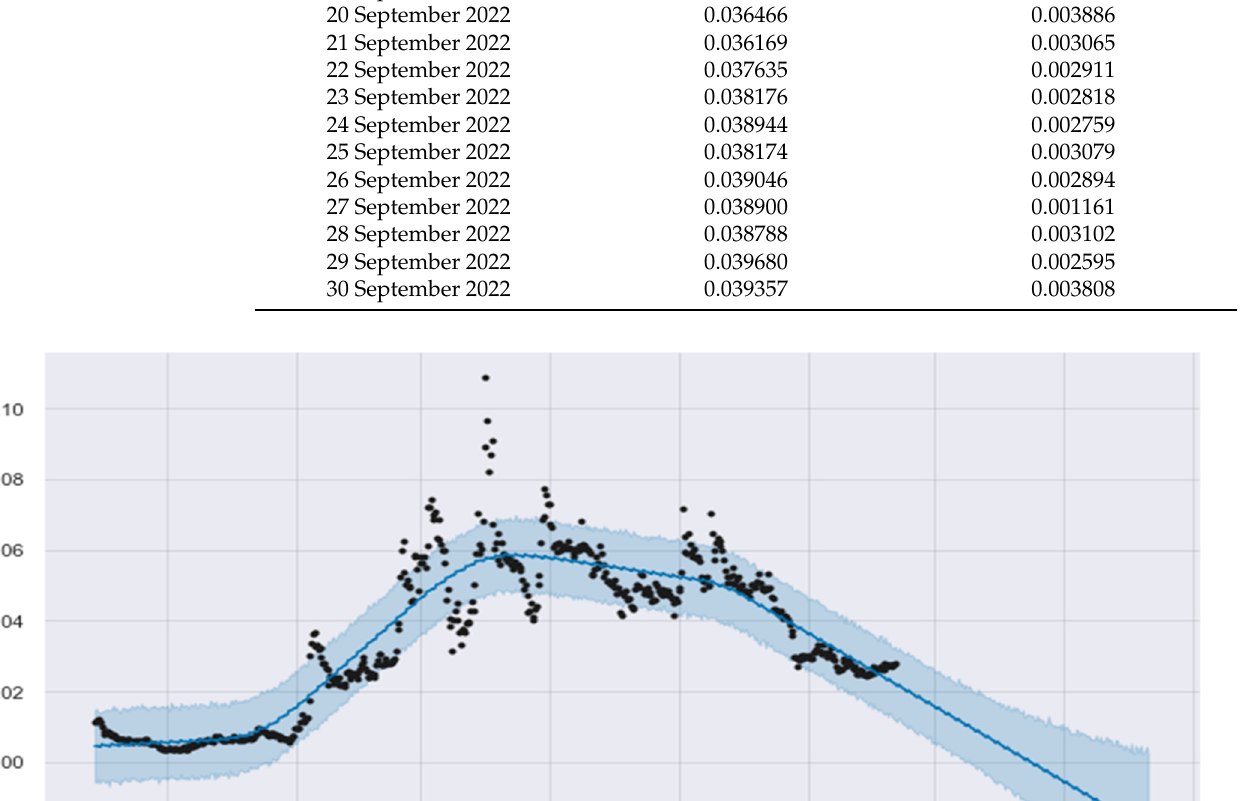
Figure 6. Error histograms of the LSTM model for predicting the price of the AMP cryptocurrency in ( a ) training and ( b ) testing.